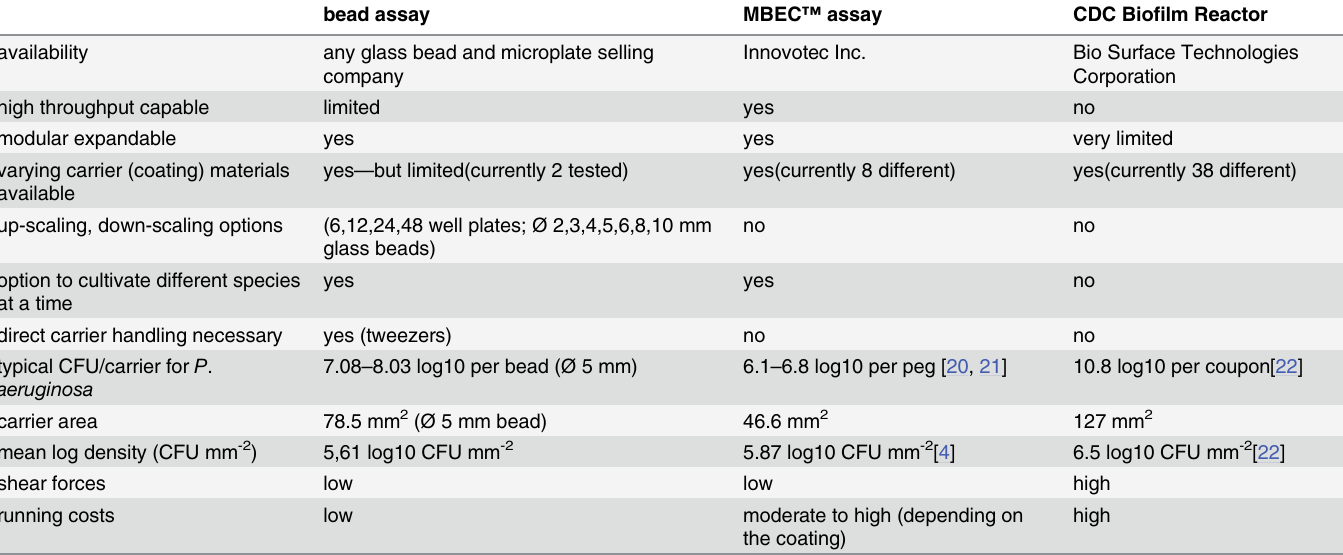
Table 1. Comparison of the bead assay, the MBEC ™ assay and the CDC biofilm reactor. bead assay MBEC ™ assay CDC Bio fi lm